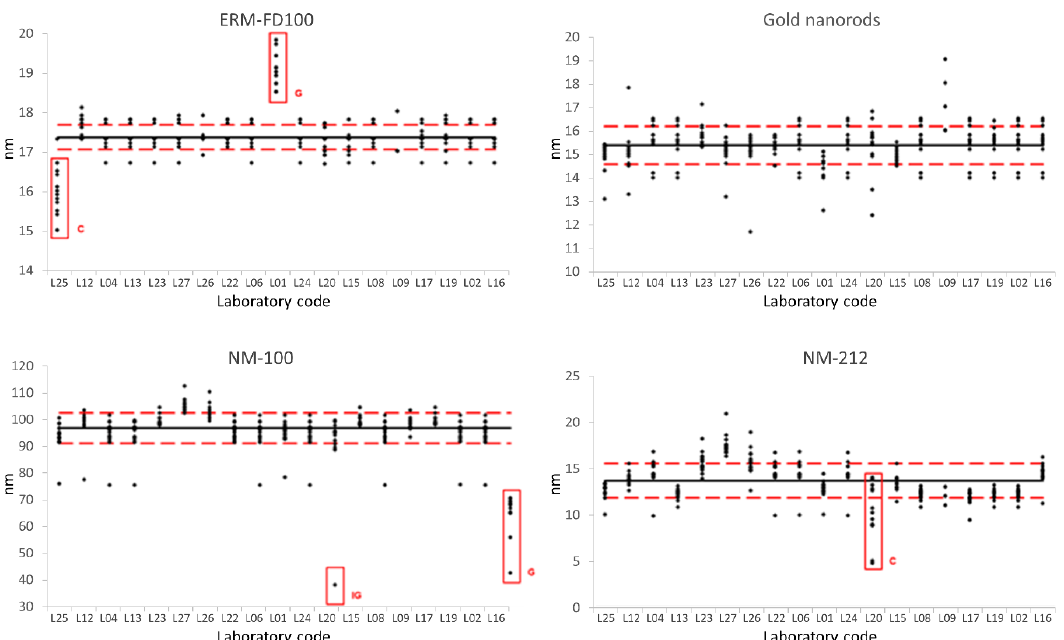
Figure 5. Performance of ParticleSizer software for ERM-FD100, Gold nanorods, NM-100, and NM-212. All replicates per laboratory are presented. The solid line refers to overall mean after outlier exclusion (C: Cochran, G: Grubbs outlier tests). Dashed lines refer to the observed acceptance range for the overall mean ( X obs ± reproducibility standard deviation, S R